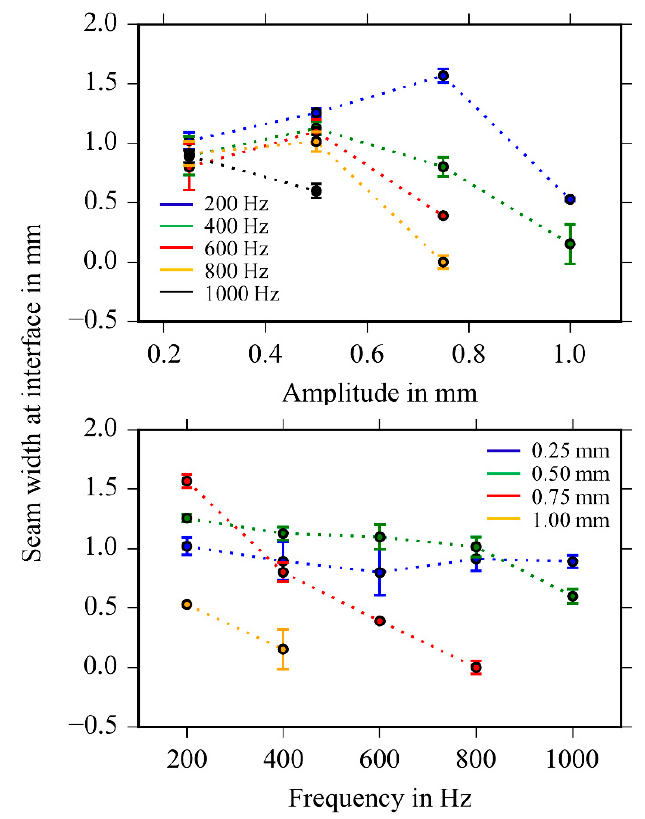
Figure 10. Seam width at the interface in dependence on the oscillation frequency and amplitude. The error bars indicate the standard deviation.